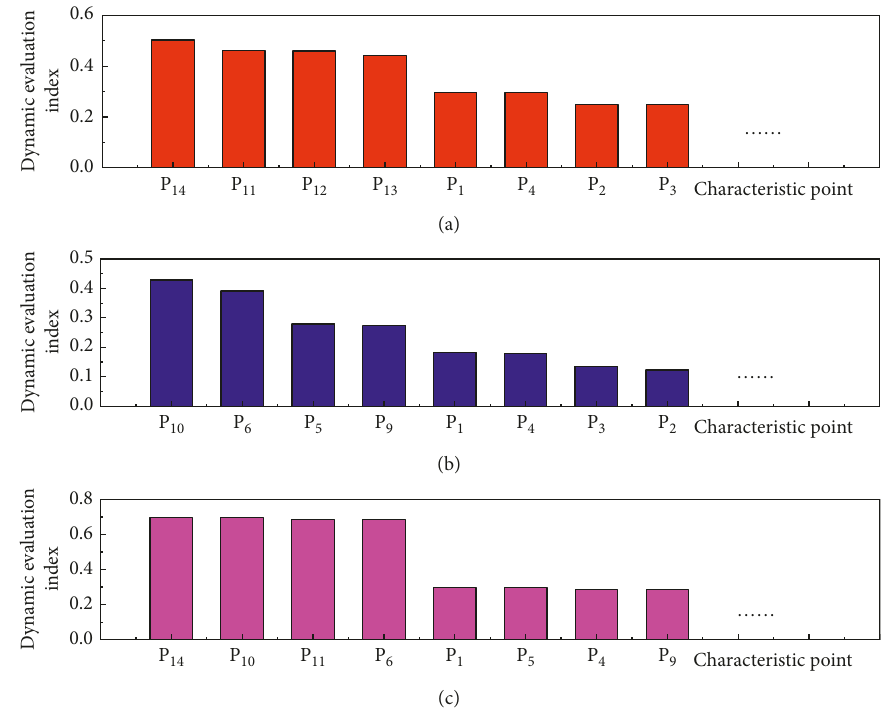
Figure 13: Comparison of the dynamic index at typical sections of the structure with 2m burial